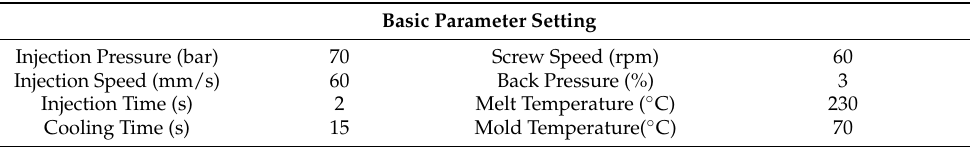
Table 1. Plasticization parameters for the manufacture of the injection molded L-FRP spiral flow test specimens.